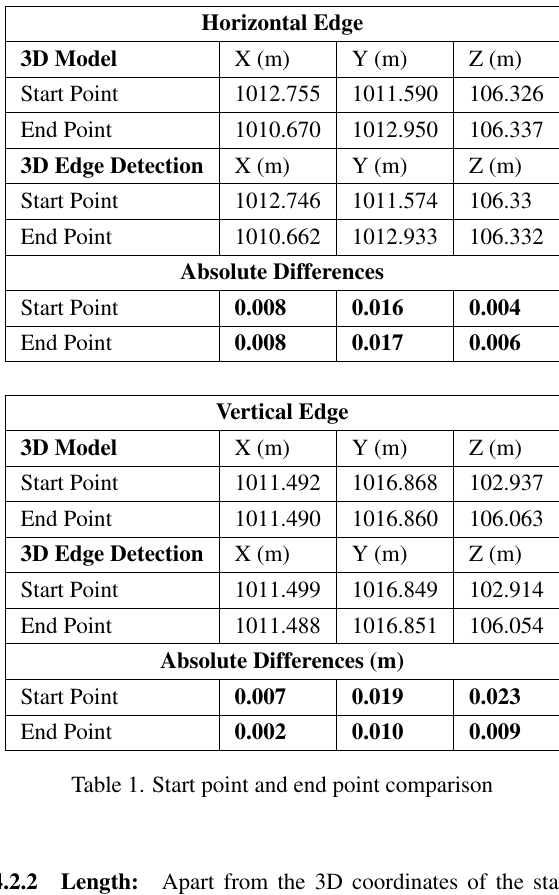
4.2.2 Length: Apart from the 3D coordinates of the start and end points, multiple observations of the length of each edge were collected. Then, the average length and the difference between the average length using the 3D model and the 3D edge detection approach, were also calculated. Each average length and the absolute difference of them are presented in Table 2.